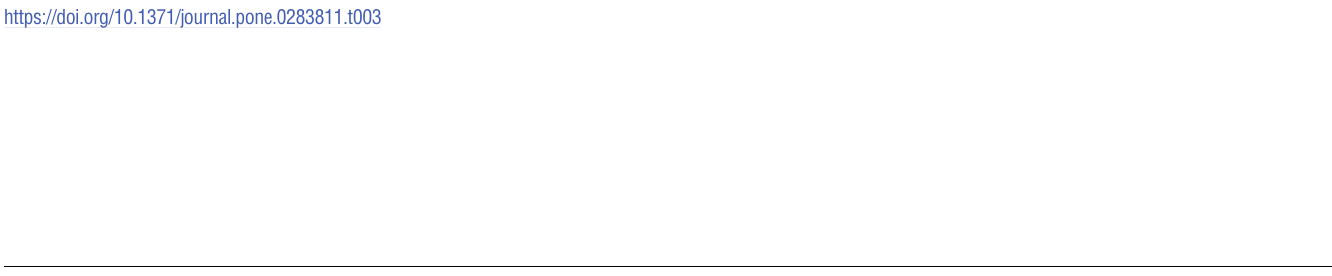
Panel B: Name Match vs. “sample size”-adjusted